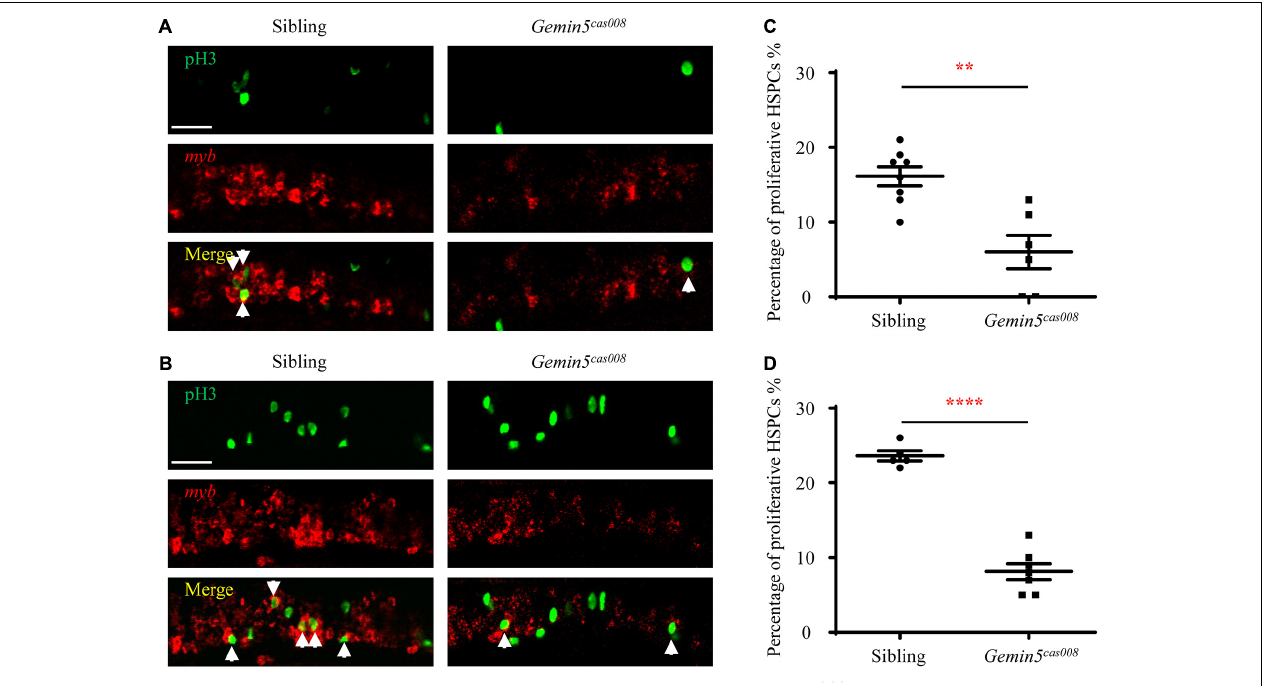
FIGURE 3 | Decreased HSPCs proliferation in mutant gemin5 cas 008 . (A,B) Representative confocal images of double staining of pH3 protein (green) and myb RNA (red) in the CHT at 4 dpf (A) and 5 dpf (B) . Arrows point at proliferative HSPCs. Scale bars, 50 µ m. (C,D) Percentage of proliferative HSPCs (pH3+myb+)/ total HSPCs (myb+) in sibling and gemin5 cas 008 embryos at 4 dpf (C) and 5 dpf (D) . (C) t = 4.202, df = 12, and P = 0.0012. (D) t = 10.96, df = 10, and P <